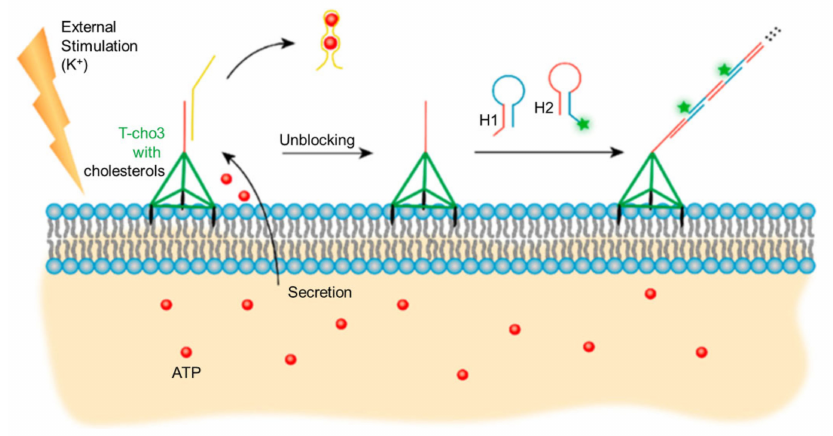
Figure 15. Scheme for trivalent binding of DNA nanoscaffolds to cell membranes and the construction of DNA nanoassemblies for fluorescent imaging. Adapted with permission from J. Am. Chem. Soc. 2021, 143, 4585–4592, doi:10.1021/jacs.0c11245. Copyright (2021) American Chemical Society